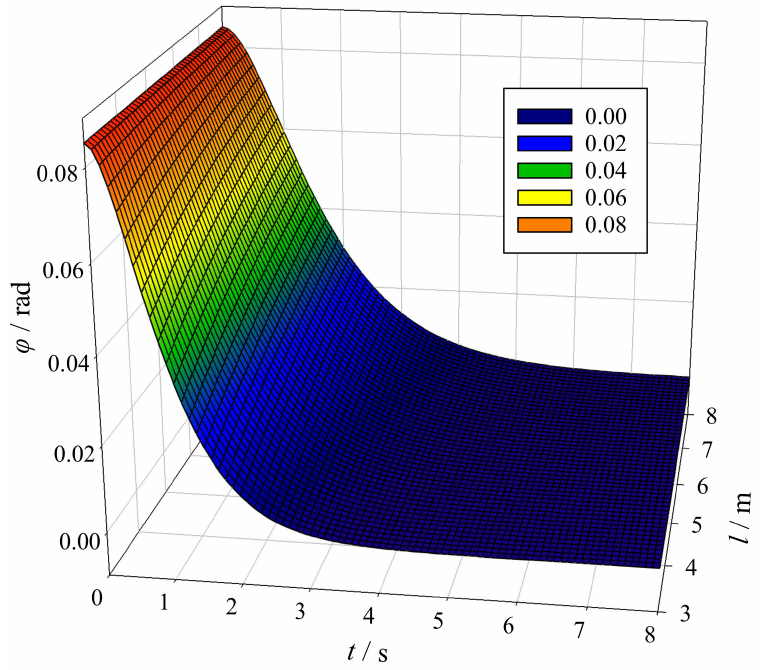
Figure 10. Influence of the hoisting rope length on the critical-damping anti-swaying system.